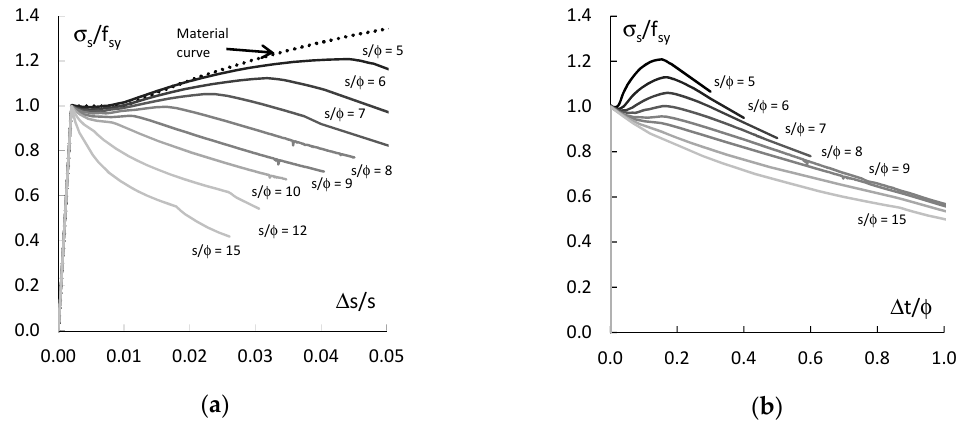
Figure 4. Behaviour of straight bars: ( a ) normalized stress versus average shortening and ( b ) normalized stress versus average lateral displacement.